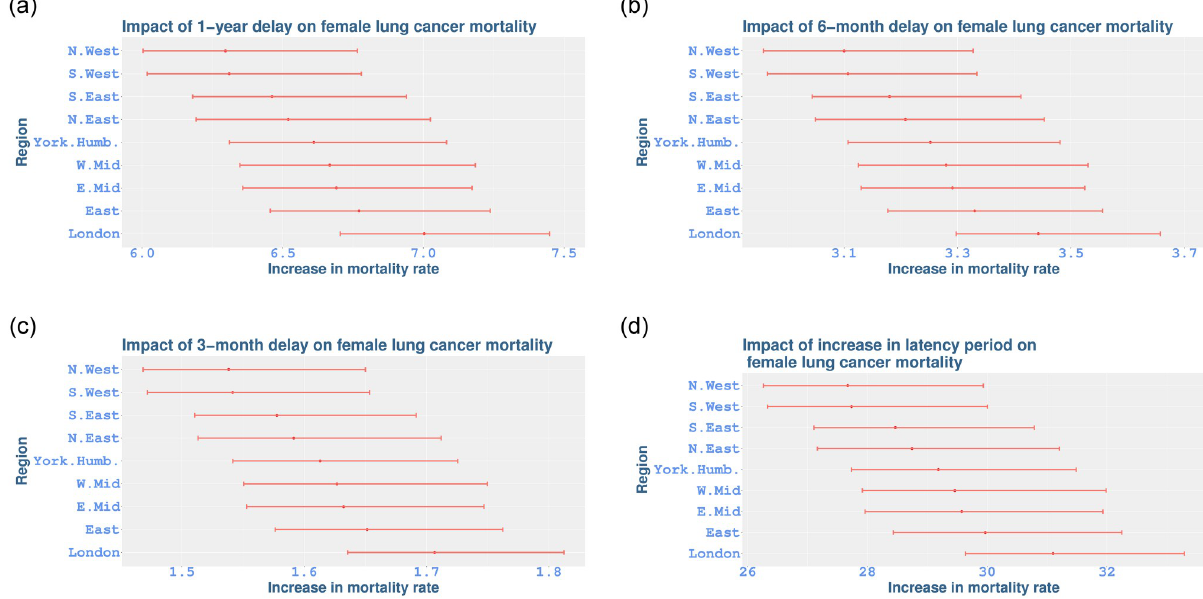
Fig 4. The impact of delay in average age-at-diagnosis for female mortality rates of trachea, bronchus and lung cancer in different regions of England. The numbers represent percentage increase in mortality rates (means shown with dots, 95% credible intervals with bars). (a) 1-year impact; (b) 6-month impact; (c) 3-month impact; (d) 4-year increase in latency period.